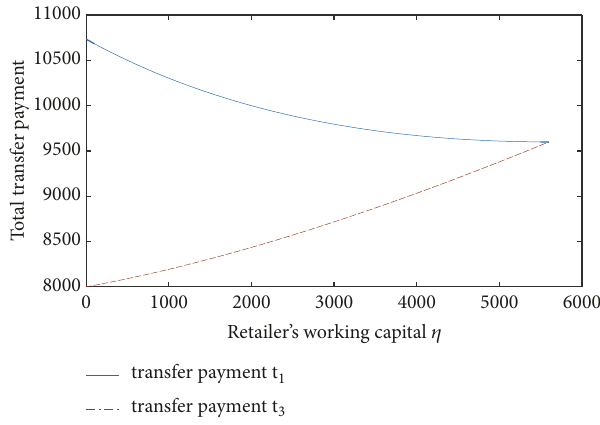
Figure 2: Change trend of total transfer payment with retailer’s working capital 𝜂 .